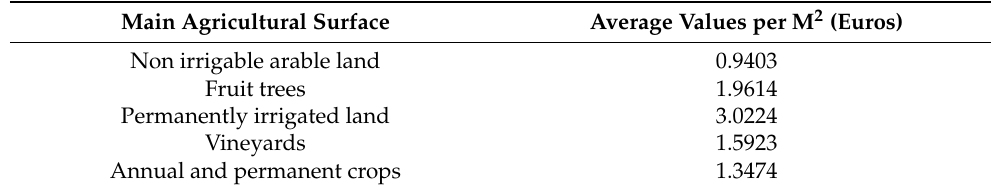
Table 1. Average values per mq of agricultural land with the same purchasing power in Sicily.